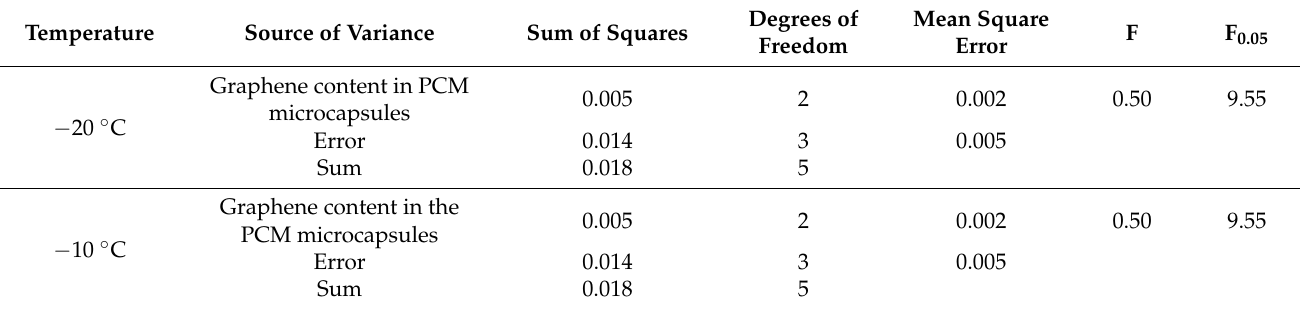
Table 7. Variance analysis of the stiffness results in the present SCB